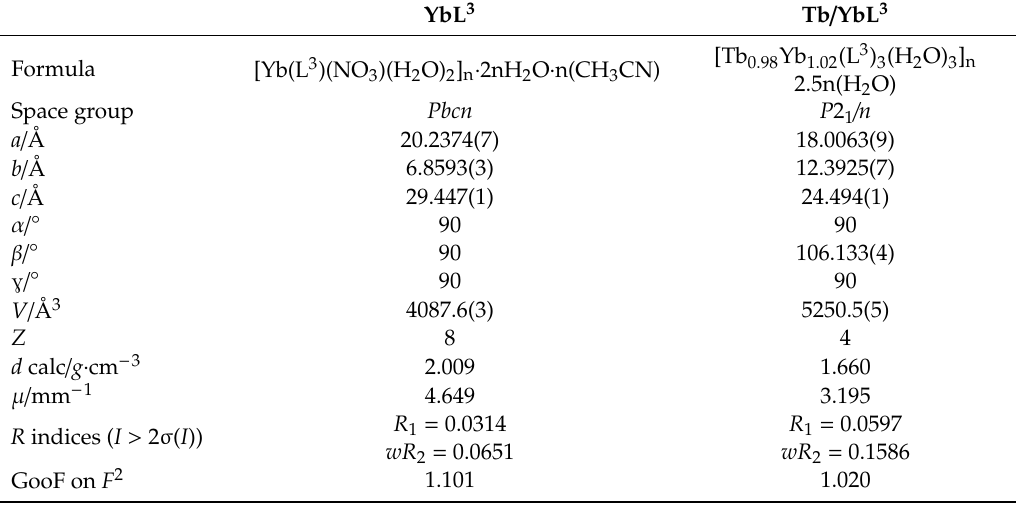
Table 2. Crystal and refinement data for YbL 3 and Tb / YbL 3 .